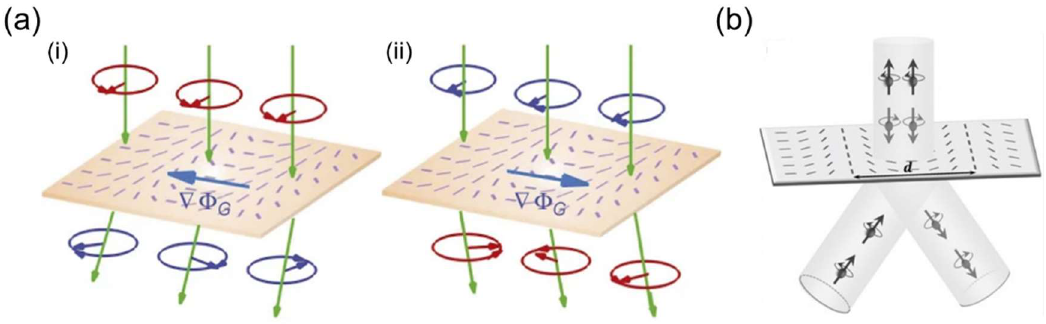
Figure 3. ( a ) Left ( i ) (right ( ii )) CP light passing through the metasurface changes its propagation direction and is converted to right (left) CP light. The arrows around the red and blue circles repre- sent left-and right-circularly polarized light, respectively [42] . ( b ) Schematic illustration of spin- dependent splitting. The spheres with arrows represent left-handed and right-handed photons, re- spectively. The PB phase of the metasurface reverses the handedness of incident photons and guides normally incident photons with opposite handedness in two directions. The small balls with arrows represent the left- and right-handed photons, respectively. Reprinted from [50] , with the permission of AIP Publishing.